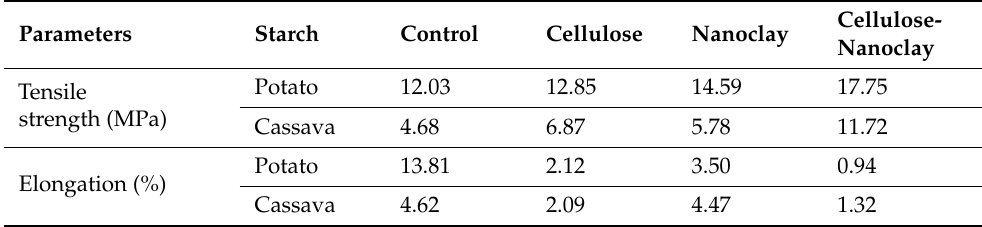
Table 9. Tensile strength and elongation at break of cassava and potato starch films with different amount of reinforcing agents [188].